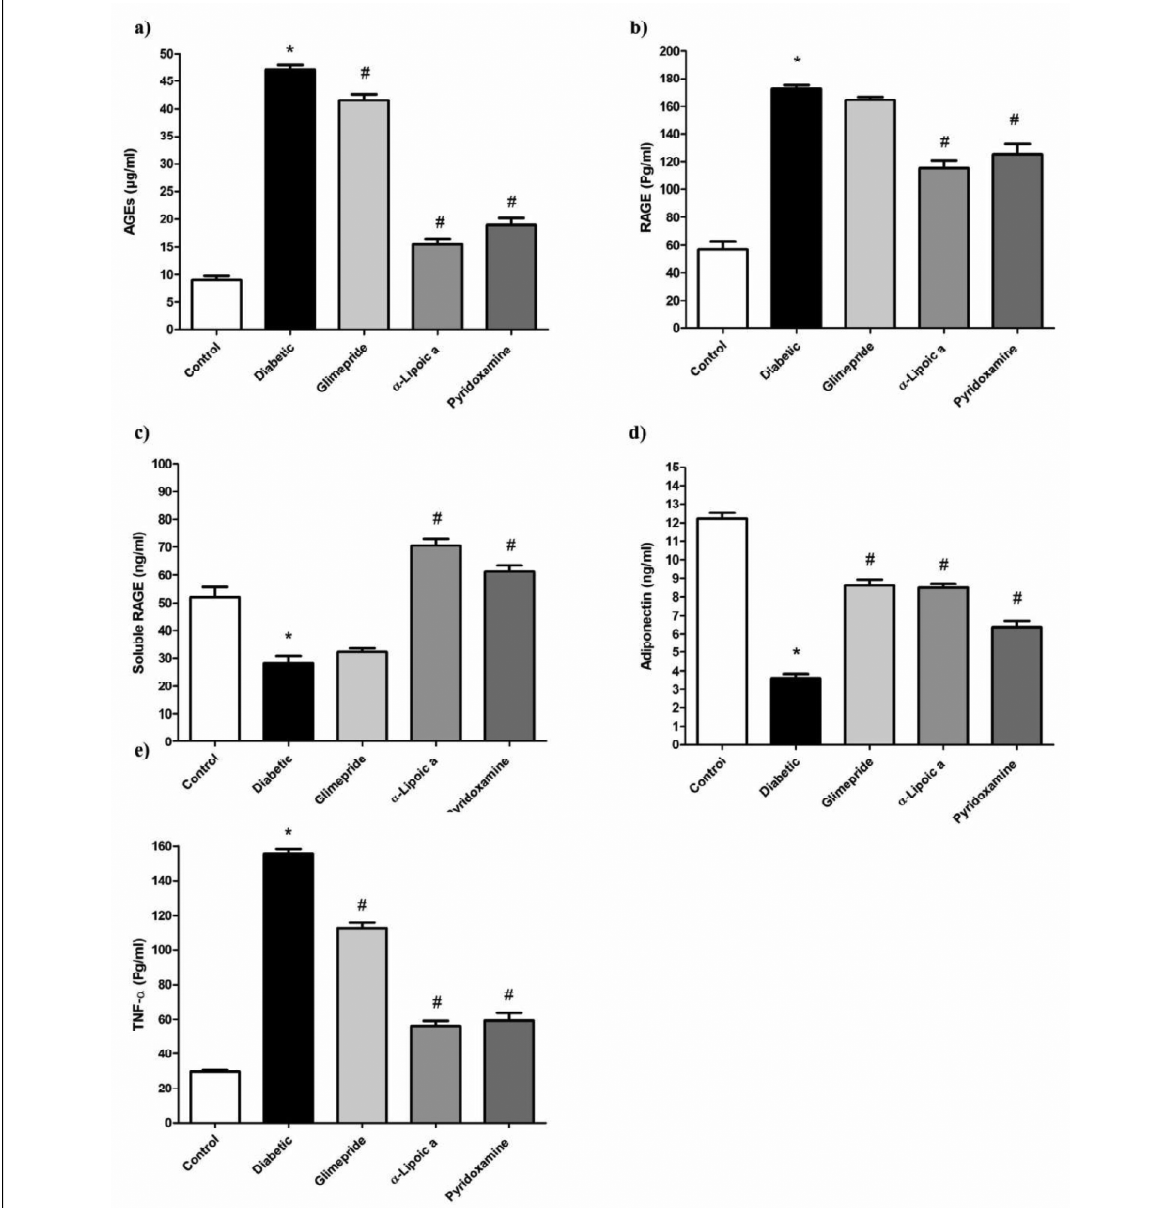
Figure 4: Effect of diabetes induction using STZ and treatment with glimepiride, lipoic acid and pyridoxamine for 8 weeks on: (a) AGEs, (b) sRAGE and (c) RAGE, (d) adiponectin and (e) TNF-  levels Note: Data are presented as mean ± SEM ( n = 6-8); * significantly different from control group, # significantly different from diabetic group at p < 0.05 using One Way ANOVA and Tukey’s post hoc